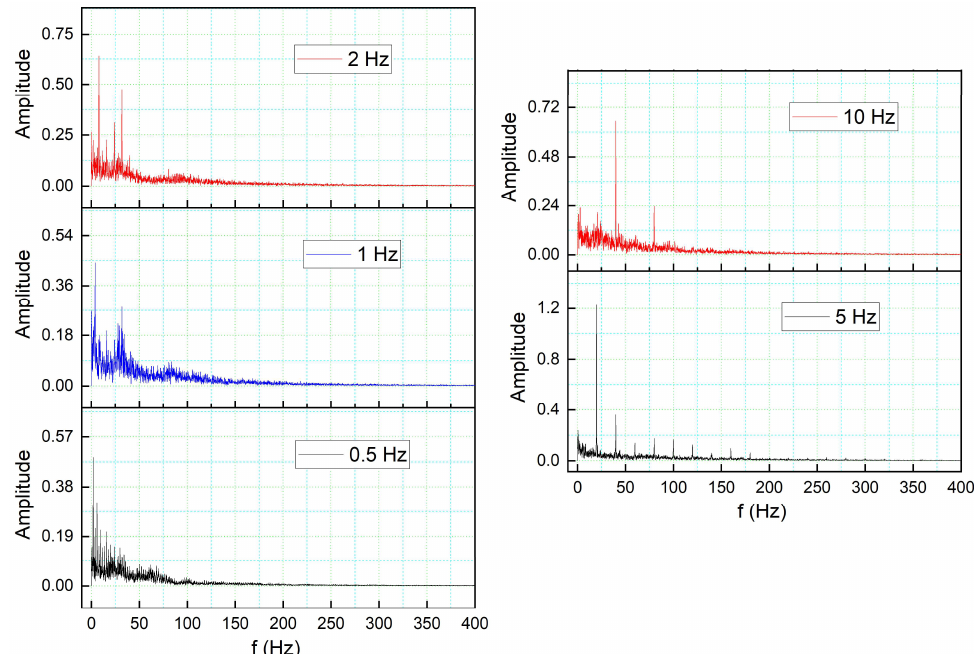
Figure 16. Lift coefficient transient responses for DMLE airfoil at 5 Hz and 10 Hz.